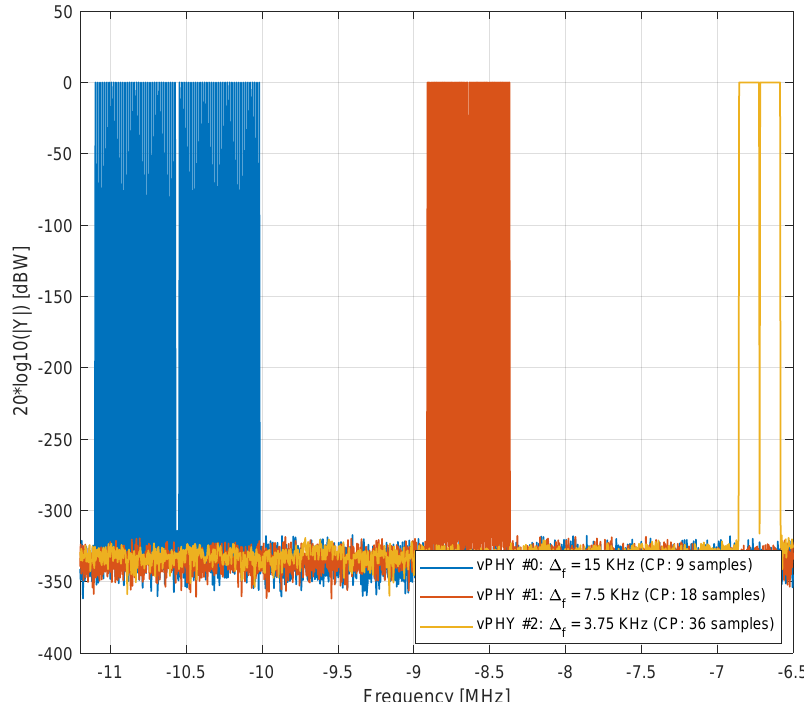
Figure 15. Frequency-domain representation of the wide baseband signal generated by the hypervisor for 3 vPHYs with uncorrelated